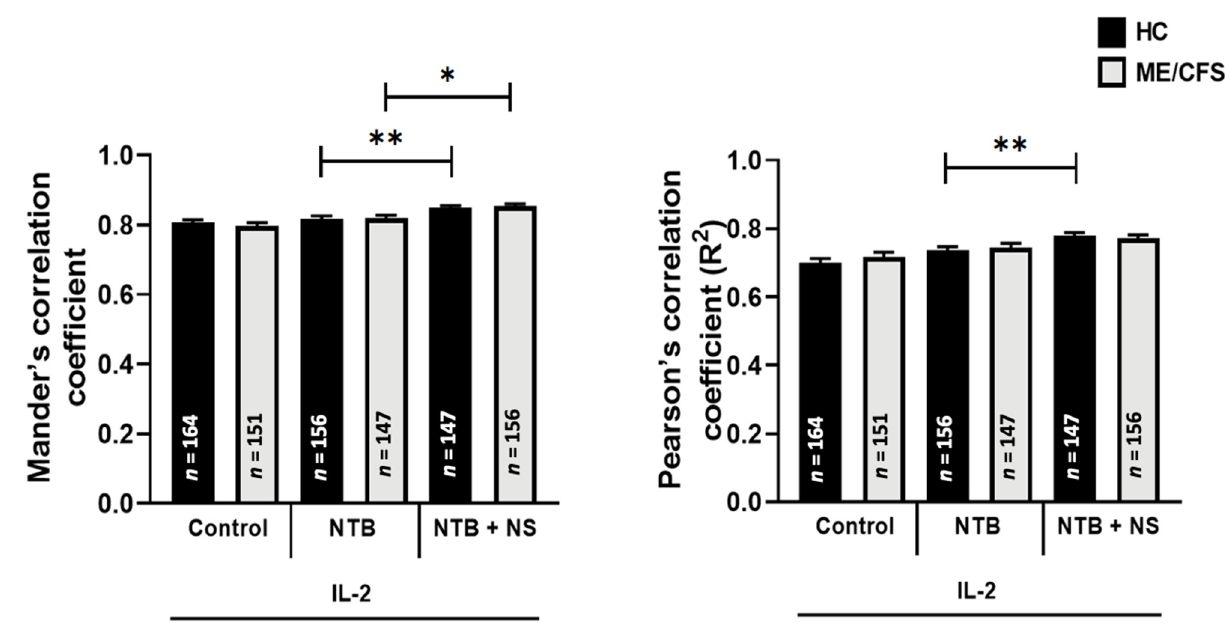
Figure 5. Co-localization of TRPM7 with PIP 2 in NK cells following IL-2 stimulation and treatment with NTB and NS8593 in HC vs. ME/CFS; n = 17 for HC and n = 17 for ME/CFS. The number of cells analyzed per condition are depicted on the bar graphs: n = 165 for HC Control, n = 151 for ME/CFS Control, n = 160 for HC NTB, n = 152 for ME/CFS NTB, n = 164 for HC NTB + NS, n = 140 for ME/CFS NTB + NS. A significantly higher co-localization of TRPM7 with PIP 2 was identified in the HC and ME/CFS cohorts following NS8593 treatment compared with the HC NTB and ME/CFS NTB conditions, respectively. No significant differences were identified between groups for each condition. Data are presented as the mean ± SEM as determined by independent Mann-Whitney U tests. * p < 0.05, ** p < 0.01. Abbreviations: healthy control (HC), myalgic encephalomyelitis/chronic fatigue syndrome (ME/CFS), natural killer (NK), NS8593 (NS), phosphoinositide 4,5-bisphosphate (PIP 2 ), transient receptor potential melastatin 7 (TRPM7).